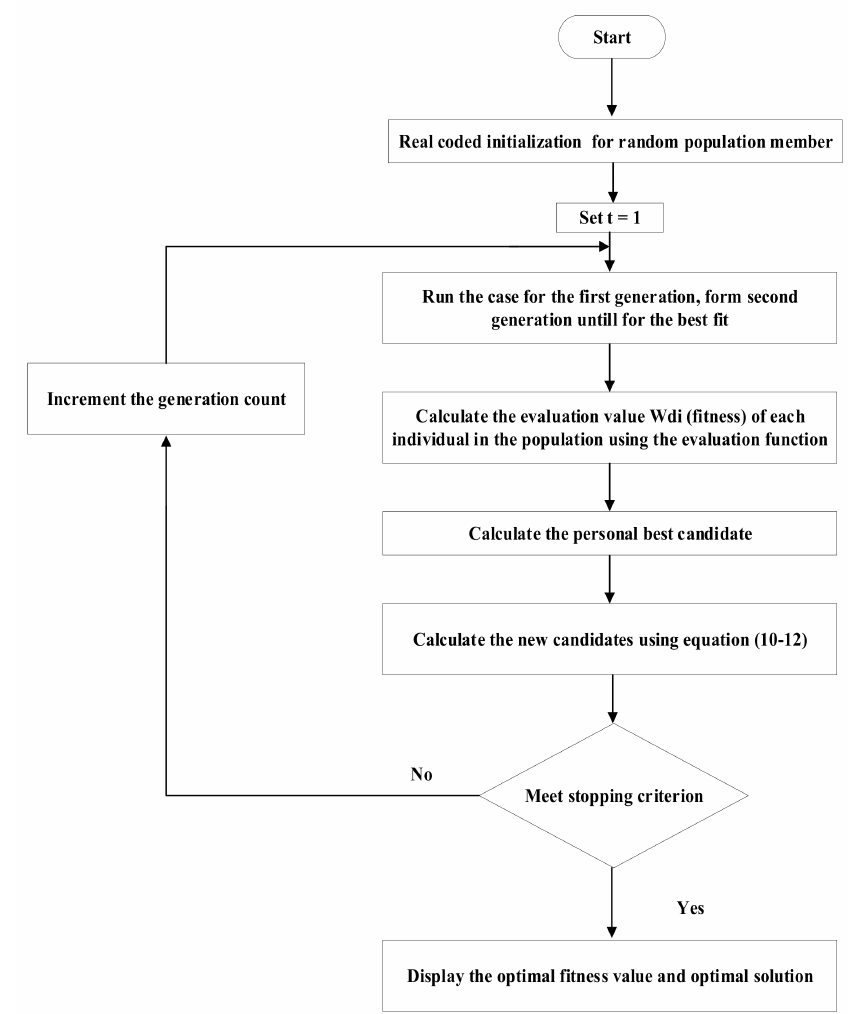
Figure 4. The flow chart of the RTO